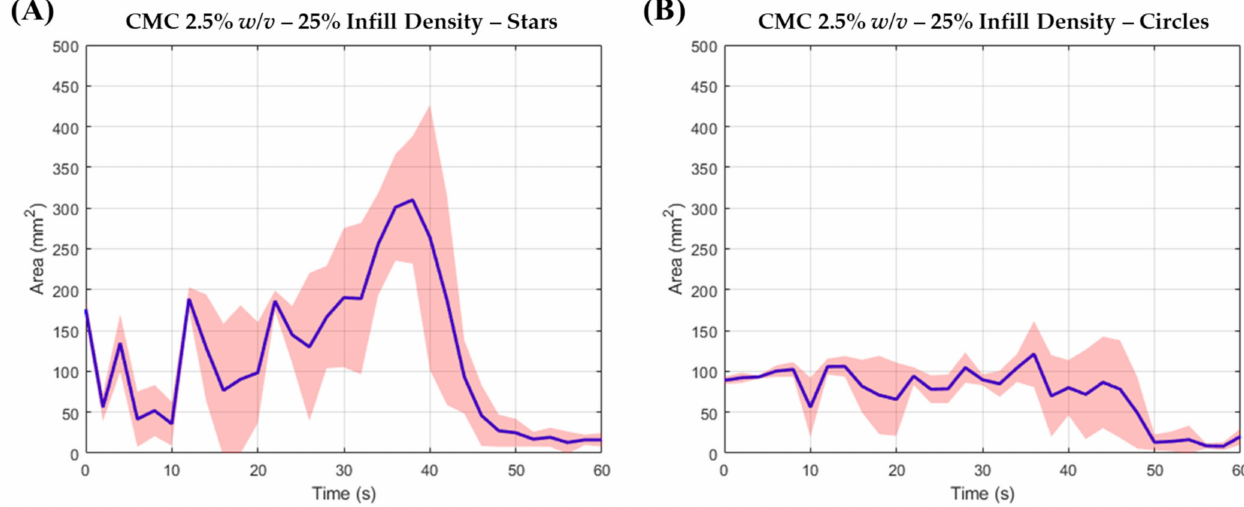
Figure 5. Mean top-down area-time profiles for ( A ) star and ( B ) circle geometries with 25% ID, assessed in the OCM ( n =